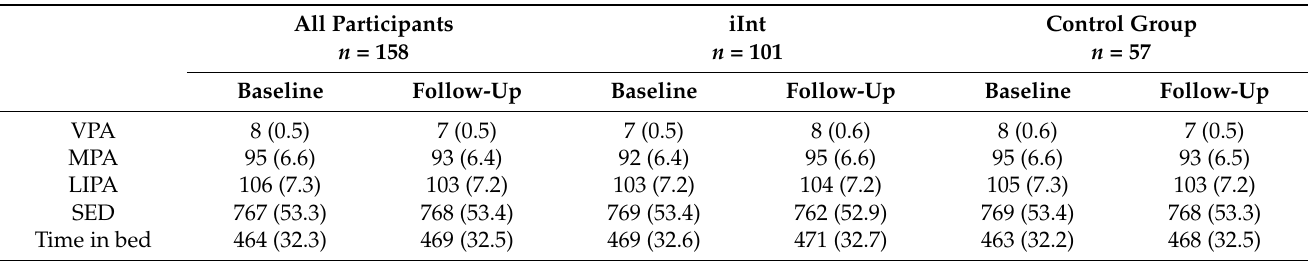
Table 4. Baseline and 6-month follow-up values for minutes spent in movement behaviors (compositional mean and % of 24-h in parentheses).